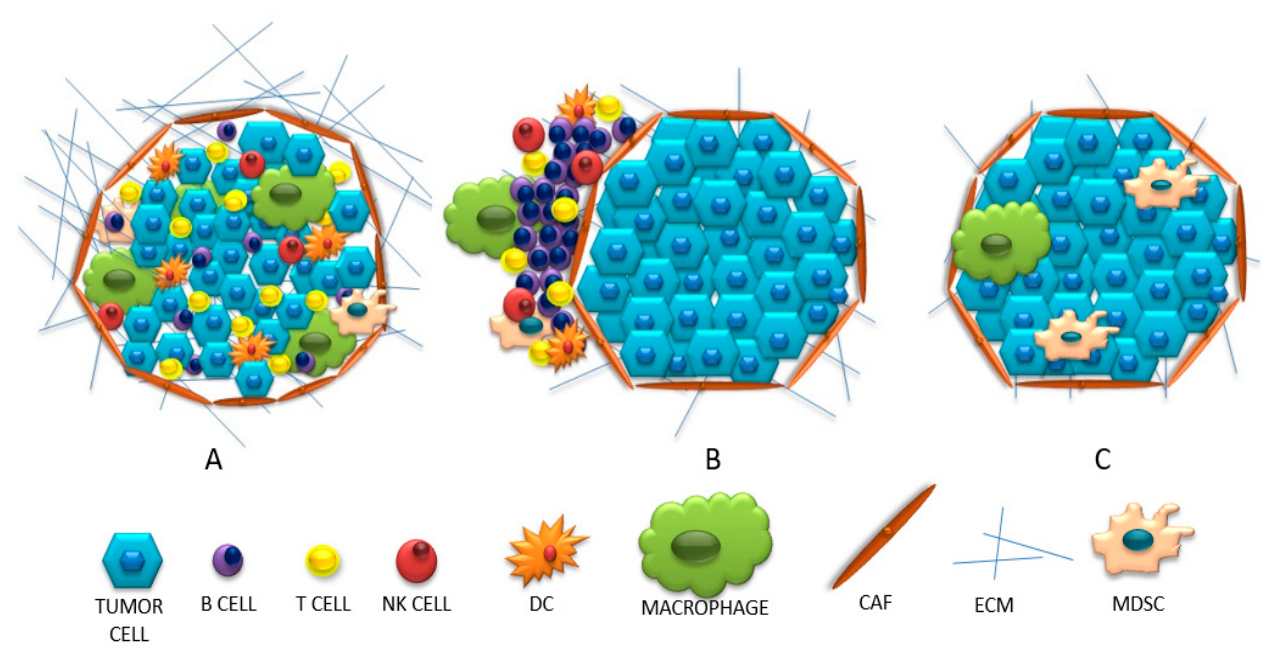
Figure 2. ( A ) “Hot” (inflamed), ( B )”cold”(excluded), ( C ) “cold “(ignored) tumors.